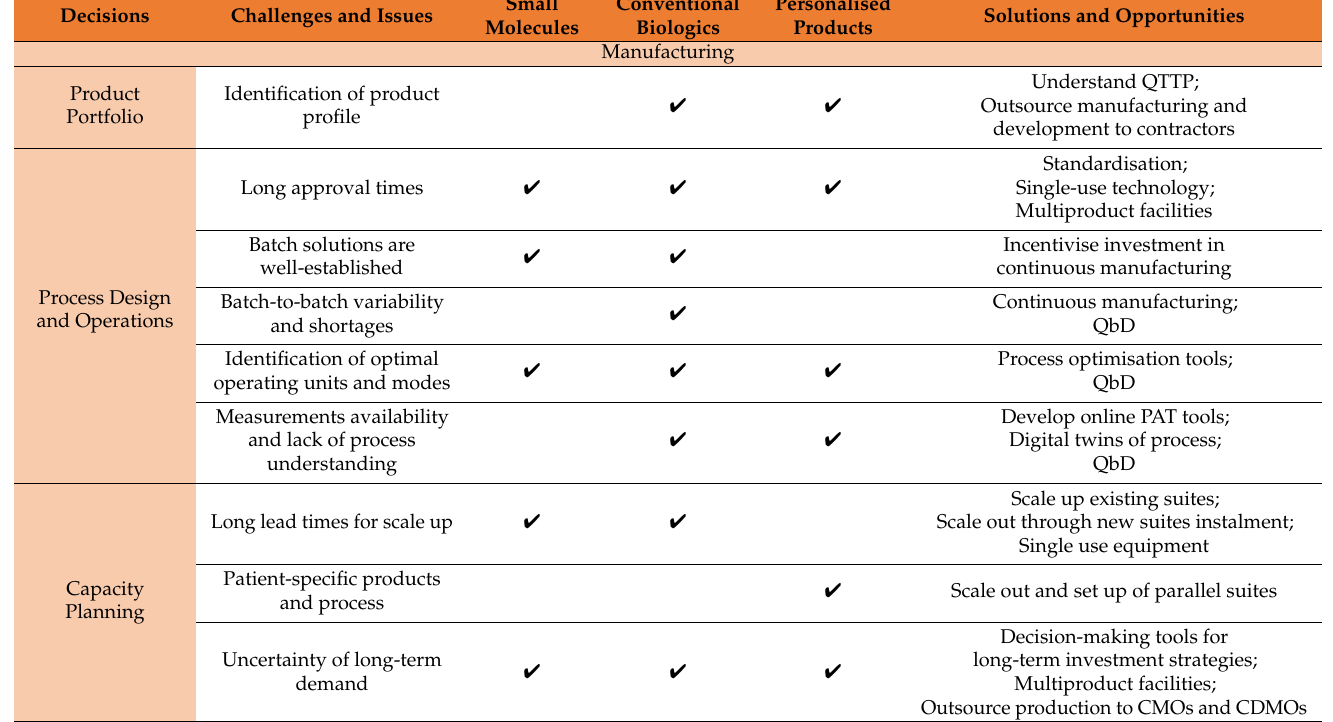
Table 1. Summary of the key challenges and opportunities in pharmaceutical manufacturing and distribution. The tick sign highlights the relevance of the identified issues and solutions to each drug product